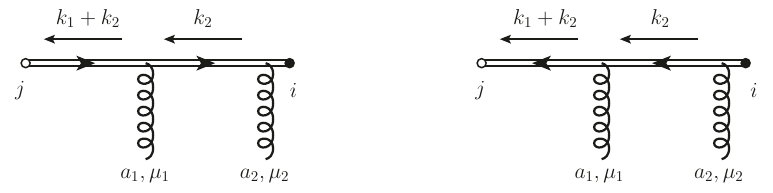
(2) (2) ( k 1 ; k 2 ) and (cid:22) ( k 1 ; k 2 ) with two gluon ij ji E E